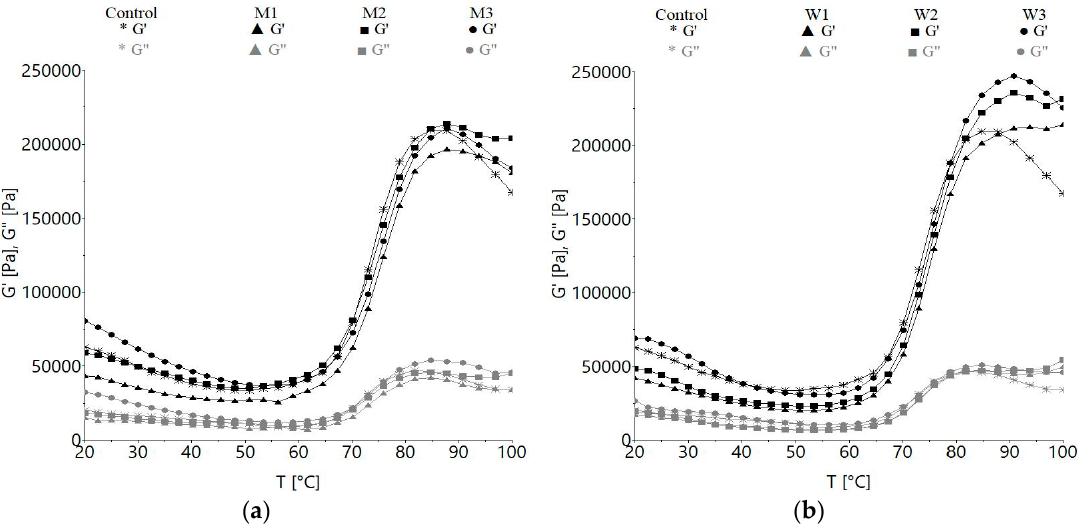
Figure 3. Effect of water replacement by: ( a ) milk: M1– 12.5%, M2—25%, M3—50%, ( b ) acid whey: W1—12.5% W2—25% W3—50%, on the changes of storage modulus ( G ’) and loss modulus ( G ”) vs. temperature.